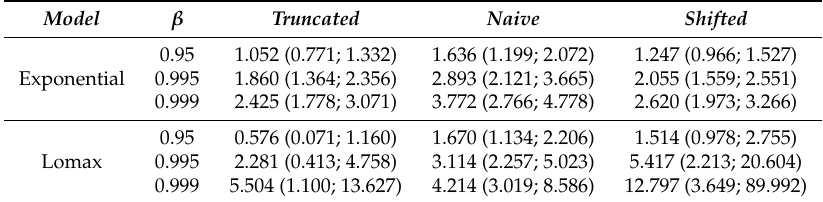
Table 6. Value-at-risk (VaR )( β ) estimates (with 95% confidence intervals in parentheses), measured in millions and based on the fitted models, using truncated, naive, and shifted approaches.